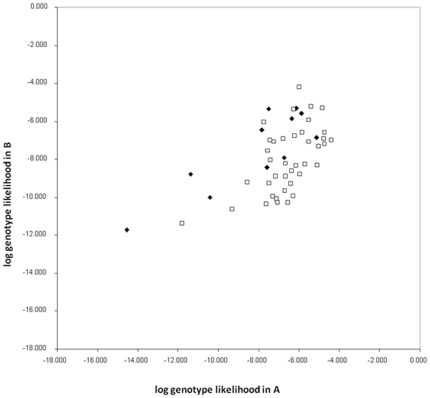
Assignment plot of genotype likelihood values of bottlenose dolphins to population A (Spencer Gulf = black squares) and B (western coastal = white diamonds).